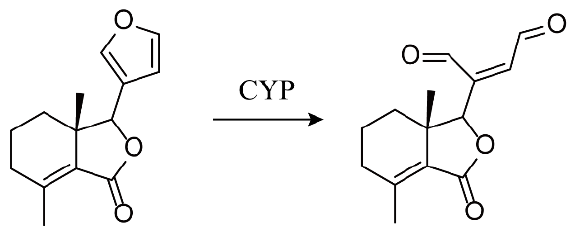
Figure 9. Chemical structures of fraxinellone (FRA) and its metabolites.